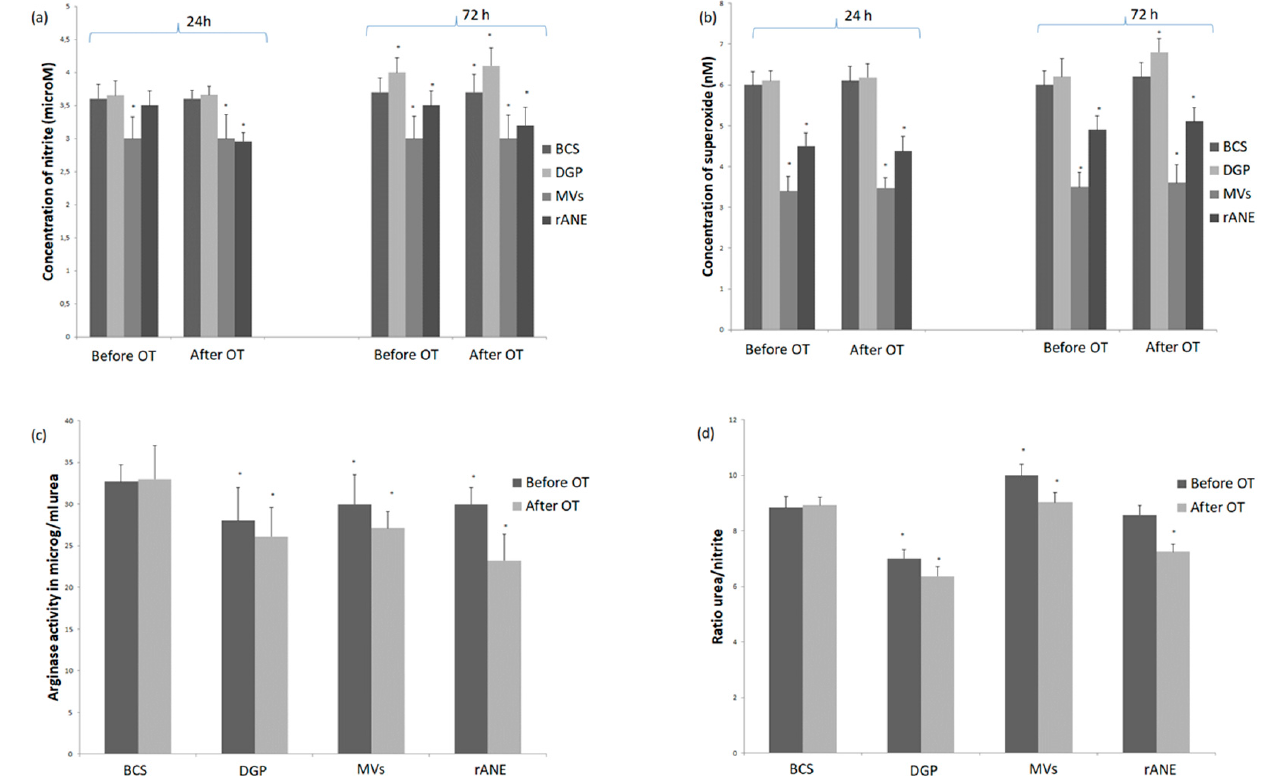
Figure 3. Generation of ( a ) nitric oxide, ( b ) superoxide and ( c ) arginase activity with ( d ) ratio urea/nitrite in monocyte- derived macrophages (MDMs) from rabbits ( n = 8) before osteochondral transplantation (OT) and 2 h after OT. Cultures stimulated only with Dulbecco’s Modified Eagle’s Medium (DMEM) with 10% bovine calf serum (BCS) and stimulated with neutrophil degranulation products (DGP), or neutrophil-derived microvesicles (MVs) or rabbit antimicrobial neutrophil extract (rANE) for 24 h and for 72 h shown in the Figure 3a,b. Data present mean values ± standard error (SE) of at least three replicates for each bar at both time points. * p < 0.05 values differ significantly compared with BCS after 24 h incubation ( a , b ). Arginase activity ( c ) and ratio urea/nitrite ( d ) in lysates of MDMs cultures stimulated with BCS, DGP, MVs or rANE. Data present mean values ± SE of at least three replicates for each bar. * p < 0.05 values differ significantly compared with BCS ( c , d ).